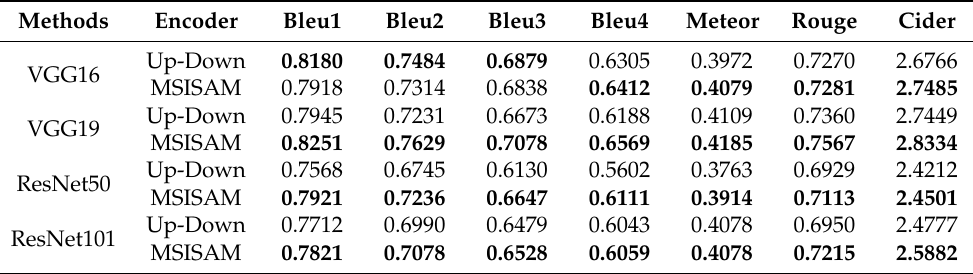
Table 7. Comparison experiments on Sydney-Captions data set [33] based on different CNNs.